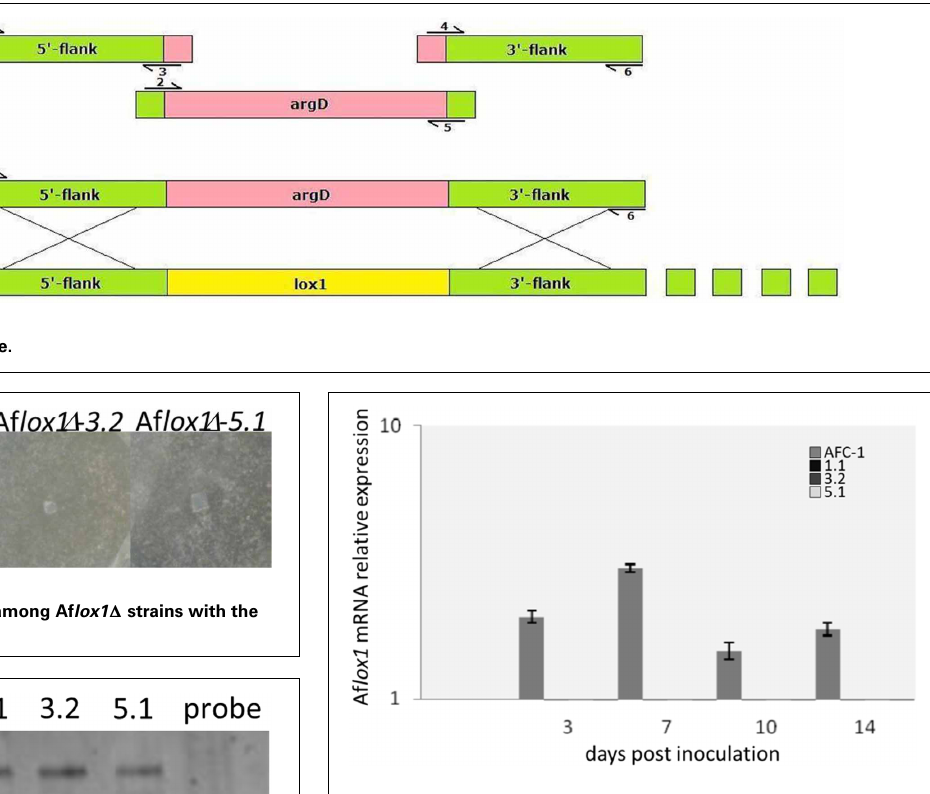
FIGURE 4 | Af lox1 mRNA relative expression normalized to Af lox1 expression at inoculation time 0 in A. flavus AFC-1 and Af lox1 deleted strains (1.1; 3.2; 5.1) in PDB at 30 ◦ C at different days after inoculation (3–14dpi). Results are the mean ( ± SE) of a total of six replications deriving from two independent